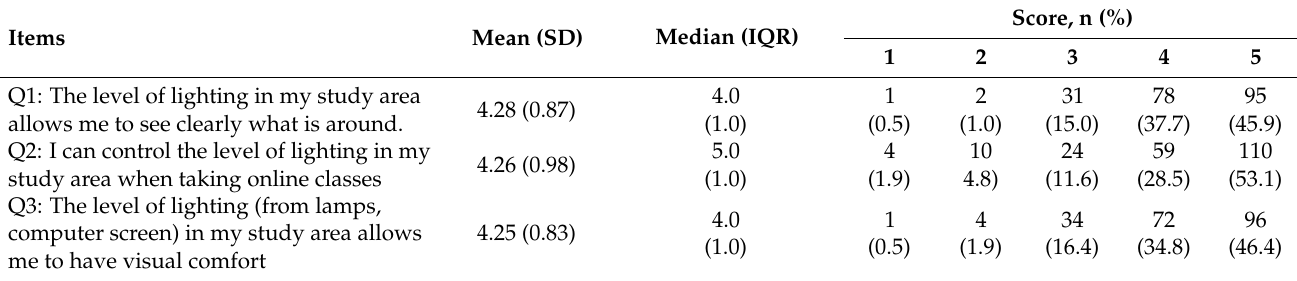
Table 3. Summary of item characteristics for LNT (n =